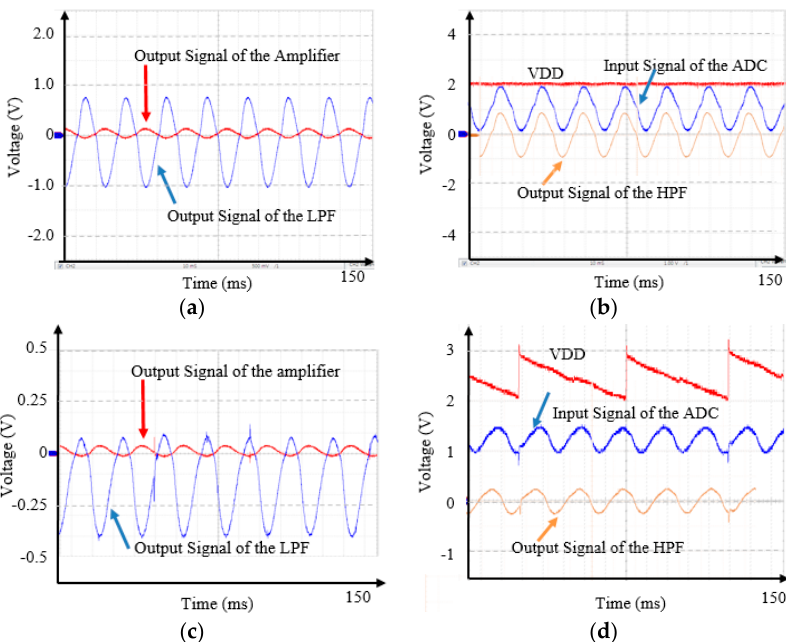
Figure 4. Measured data signals. ( a ) Output signals of the amplifier and the low pass filter (LPF) at Cs = 1 mF, ( b ) the positive supply voltage (VDD), the output signal of the high pass filter (HPF), and the input signal of the analog-to-digital converter(ADC) at Cs = 1 mF, ( c ) output signals of the amplifier and the LPF at Cs = 0.33 uF, and ( d ) the positive supply voltage VDD, the output signal of the HPF, and the input signal of the ADC at Cs = 0.33 uF.